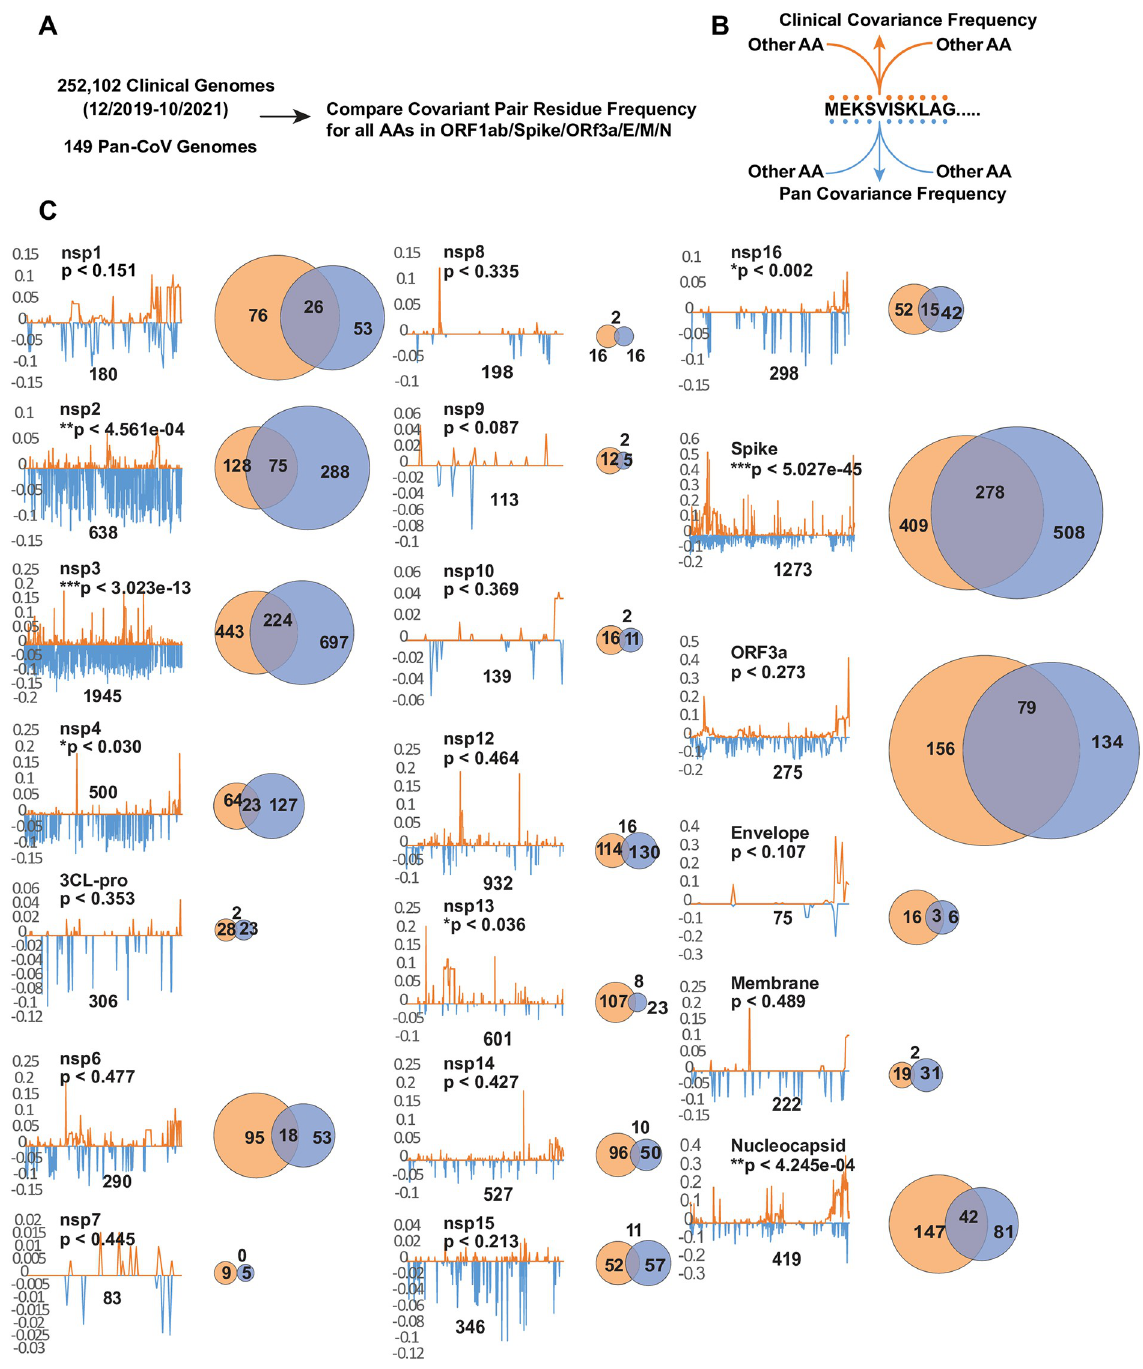
Fig 4. Comparing individual covariant residues in clinical and pan analyses in conserved genes. (A and B) Outline of comparative analysis. (C) Trace showing the position and frequency of both Clinical (orange) and Pan (blue) identified covariant residues in each gene. The length of the SARS-CoV-2 gene is labeled and the number of covariant residues in each is indicated with the number overlapping in a Venn diagram. The size of each Venn circle is proportional to the percentage of residues identified in each gene., The significance and P-value calculated for each gene based on the length of the gene, number of covariant residues in each, and overlap is shown.